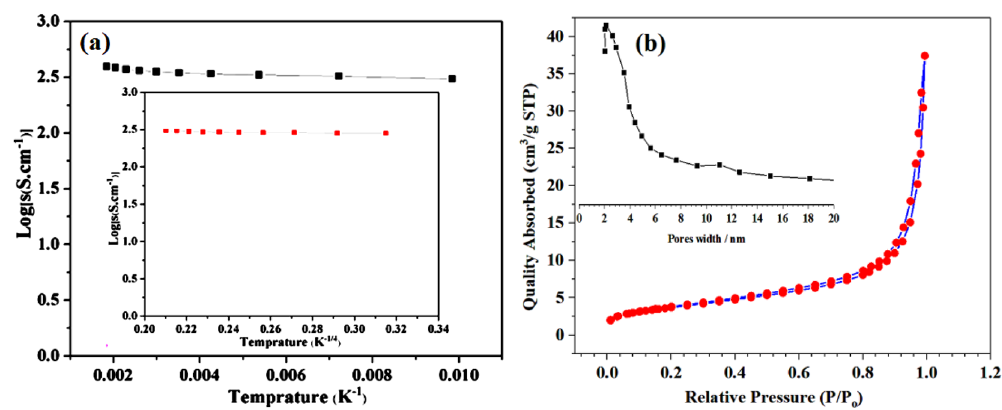
Figure 6. ( a ) Conductivity measurements, and ( b ) BET surface area of C 12 A 7 − x Fe x :e − , where doping level, x =